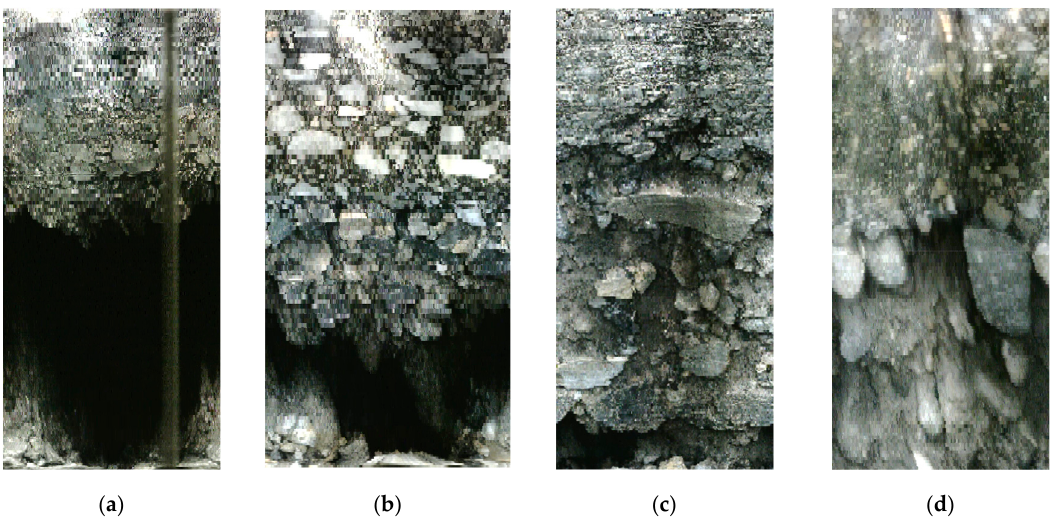
Figure 9. In-situ validation tests with ( a ) multi-channel GPR-mounted van and ( b ) core drilling. Figure 10. Representative core drilling results of ( a , b ) cavities and ( c , d ) gravels. A total of 1,056 GPR grid images of 256 cavities, 256 manholes, 256 subsoil backgrounds, and